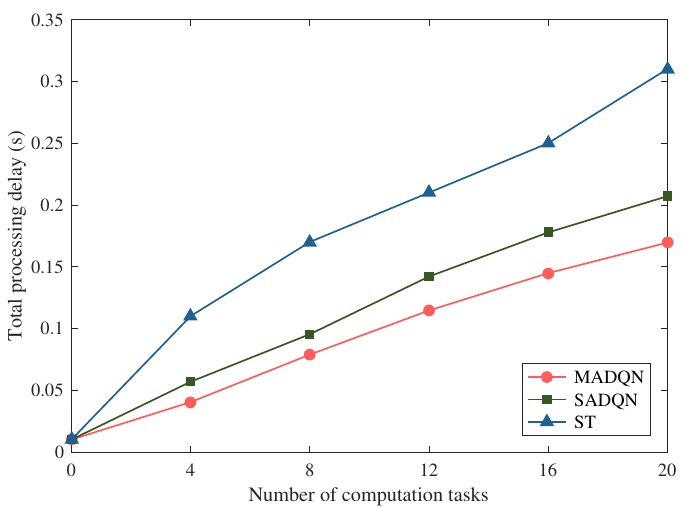
Figure 10. The effect of the number of computation tasks on the total processing delay.